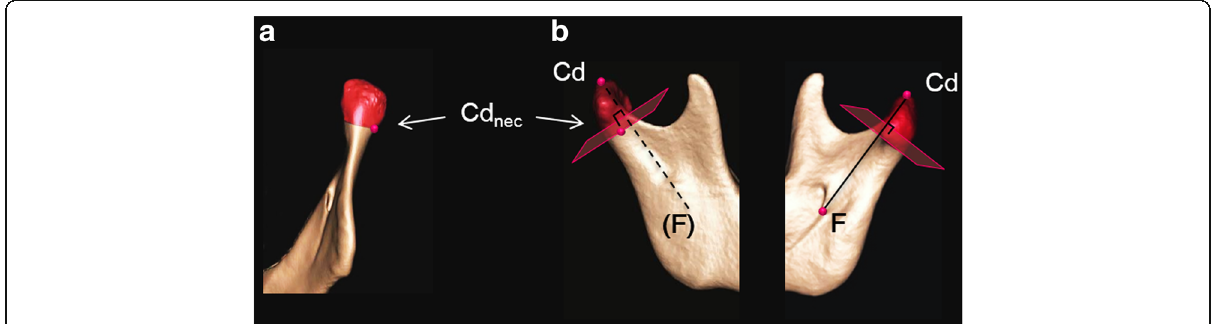
Fig. 2 A plane was established that perpendicularly intersected with the Cd – F line and passed through Cd neck . The condyle was defined as the structure superior to this plane (red area). a Posterior view of ramus. b Exterior view (left) and interior view (right) of